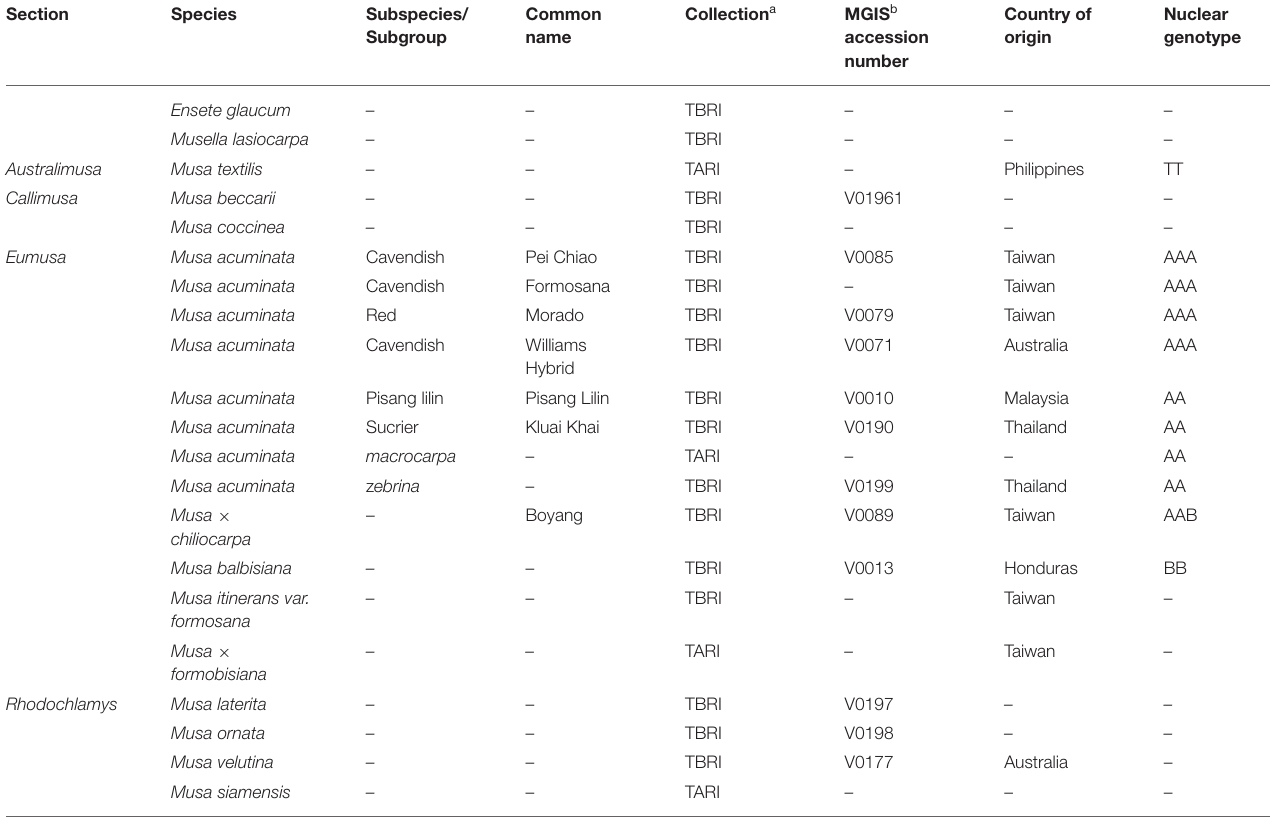
TABLE 1 | List of the 21 Musaceae species sequenced in this